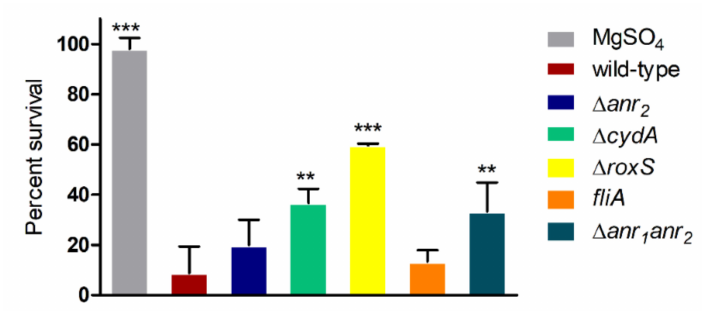
Figure 5. Virulence of B. cenocepacia H111 strains in G. mellonella after 48 h. Y-axis, % of survival. At least three biological replicates were performed with 10 G. mellonella for each sample (wild-type n = 9, ∆ roxS n = 7, MgSO 4 n = 5, all other samples n = 3). Error bars represent SD, one-way ANOVA was performed (Dunnett) with confidence interval of 99%, p -value ** < 0.01, *** <